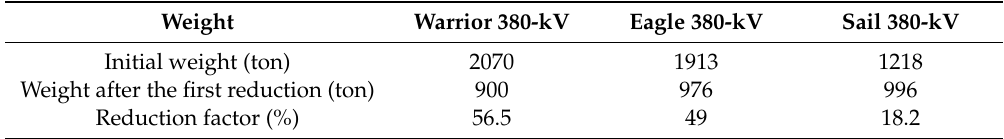
Figure 12. Topology optimization results: First weight reduction. ( a ) Capestrano Warrior statue; ( b ) Eagle; ( c ) Sail. Table 9. Weight reduction after the first topology